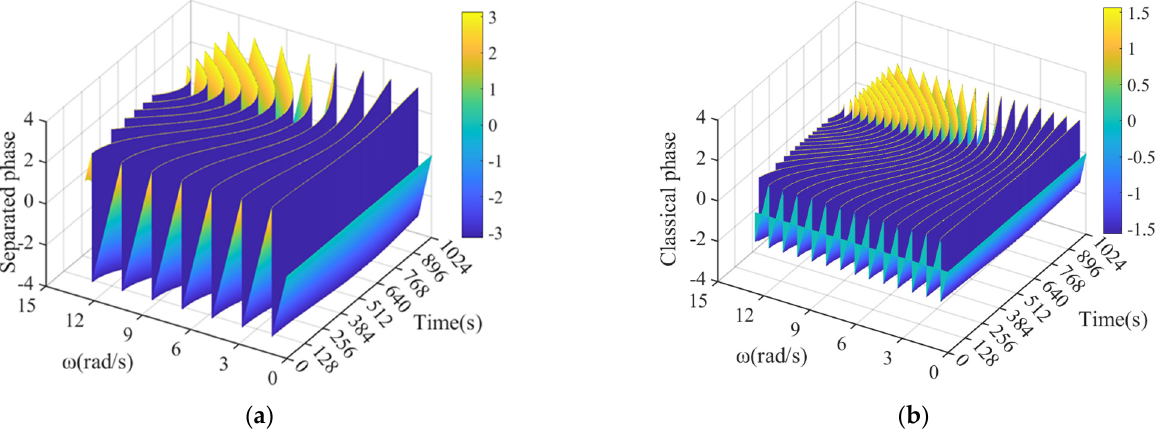
Figure 9. Time-varying phases obtained by two schemes: ( a ) separated phase; ( b ) classical formulation.